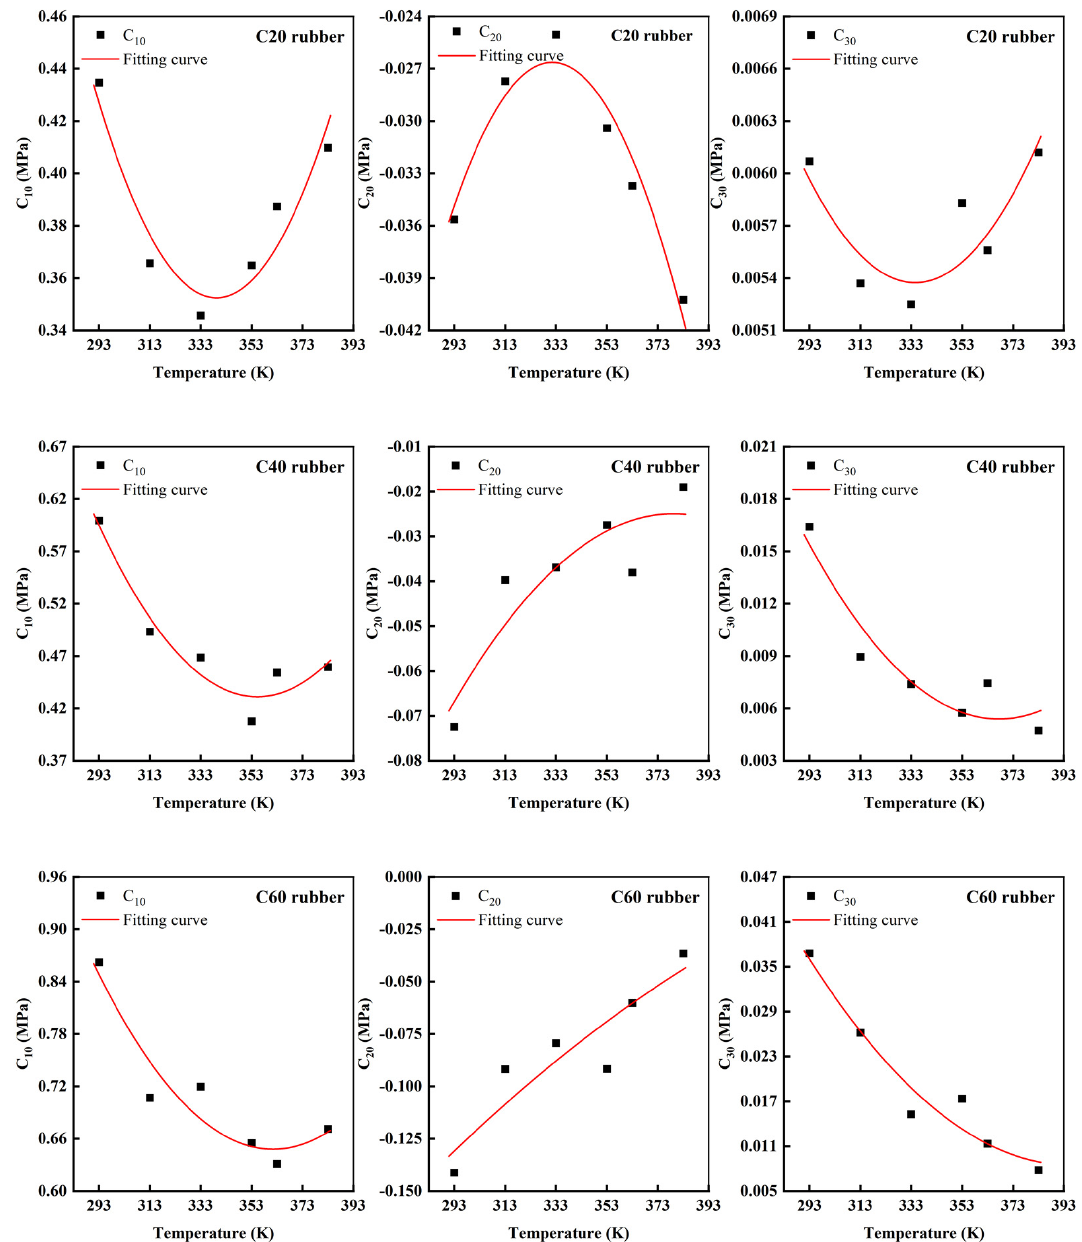
Figure 6. Temperature—dependent quadratic function fitting curves of parameters of the Yeoh constitutive model for four types of rubbers.